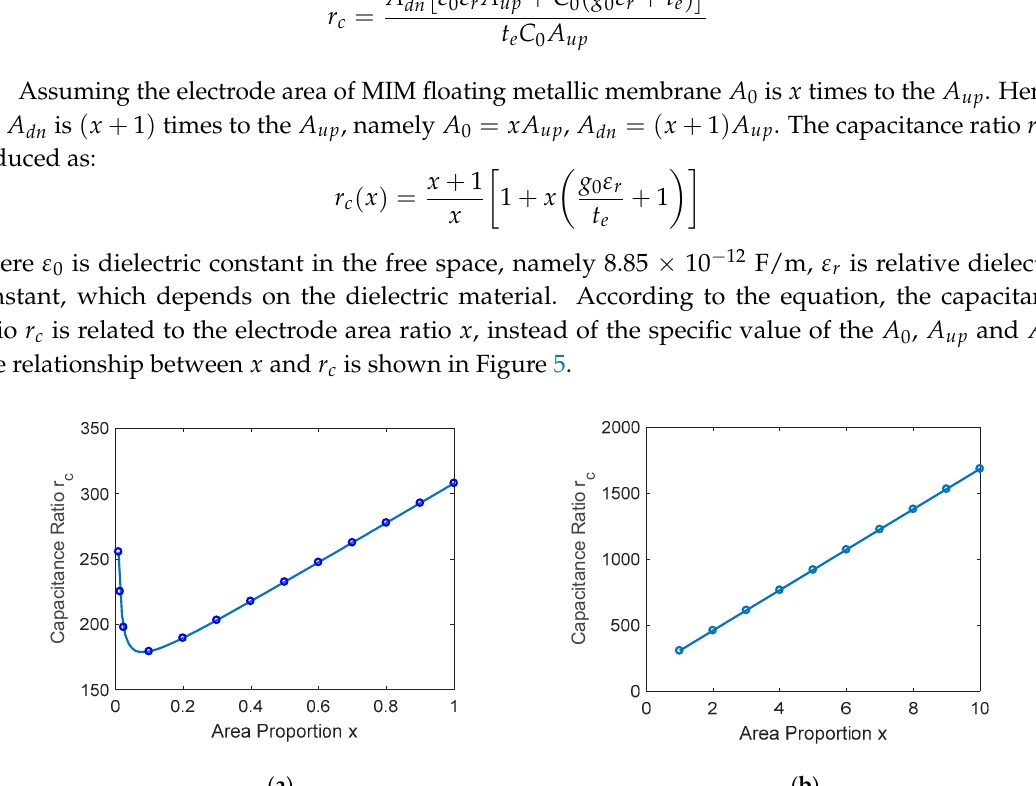
Figure 5. The relationship between (cid:1876) and (cid:1870) (cid:3030) . ( a ) (cid:1876) ∈ (cid:4670)0,1(cid:4671) ; ( b ) (cid:1876) ∈ (cid:4670)1,10(cid:4671) .